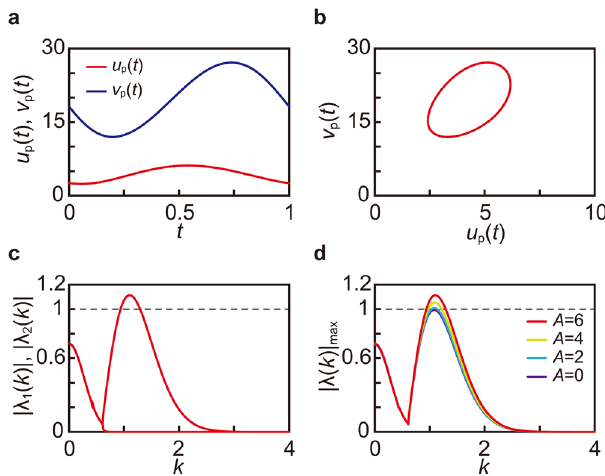
Fig. 4 Linear stability analysis of the Turing system with a periodic forcing of the feed concentration. Plots of u p t ð Þ (red) and v p t ð Þ (blue) for t ð Þ and v t ð Þ in the phase space ( u – v plane) A = 6 ( a ). Plot of the or bit of u (cid:4) (cid:4) (cid:4) (cid:4) p p (cid:4) (cid:4) and λ (cid:4) (cid:4) as a function of k for A = 6 ( c ). k ð Þ for A = 6 ( b ). Plots of λ 1 k ð Þ 2 Plots of j λ k ð Þj as a function of k for various A ( d ). The other parameters max were set as a ¼ 22 ; σ ¼ 8, b = 1.9, c = 1.5, T = 1, and N = 10,000.